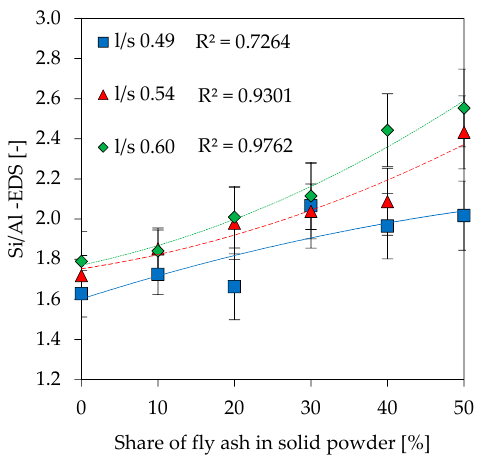
Figure 14. Si/Al ratio measured by energy dispersive spectroscopy (EDS) (Si/Al-EDS).